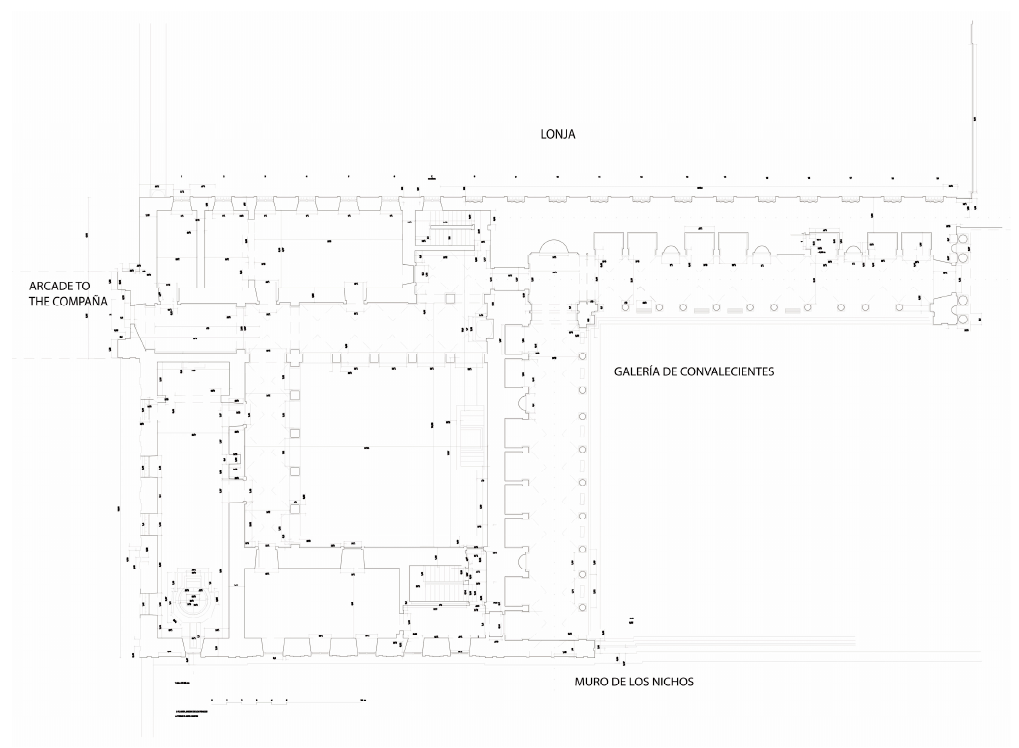
Figure 16. Pilar Chías and Tomás Abad, 2017: Ground plan of the complex of the Botica and Galería de Convalecientes at the level of the Jardín de los Frailes . Original scale 1:50.